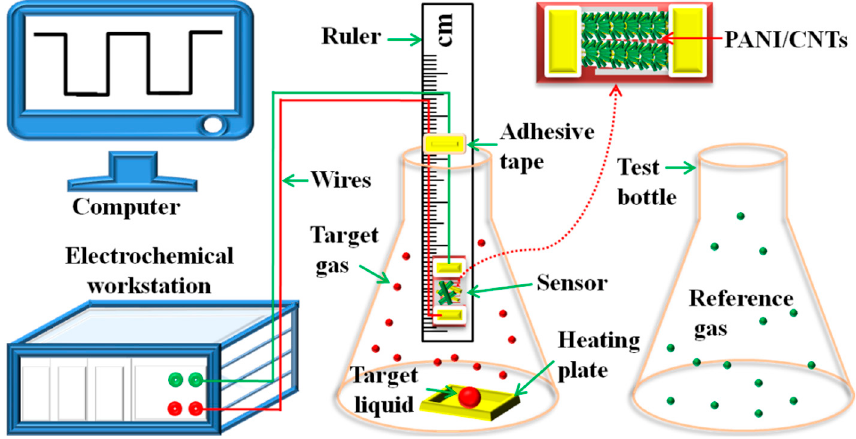
Figure 1. Schematic of sensing test for chemiresistive sensor of hierarchical PANI/CNT fibers.